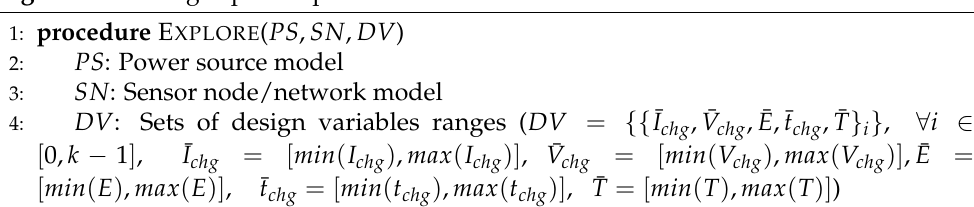
Algorithm 1 Design space